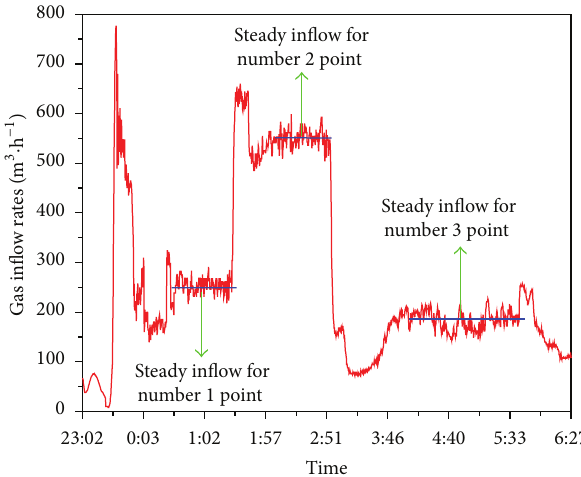
Figure 11: Three segments of steady inflow obtained by introducing fluctuation at the bottom hole pressure.